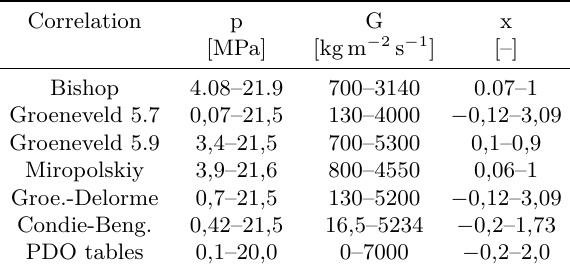
Table 1. Validity range of used post CHF